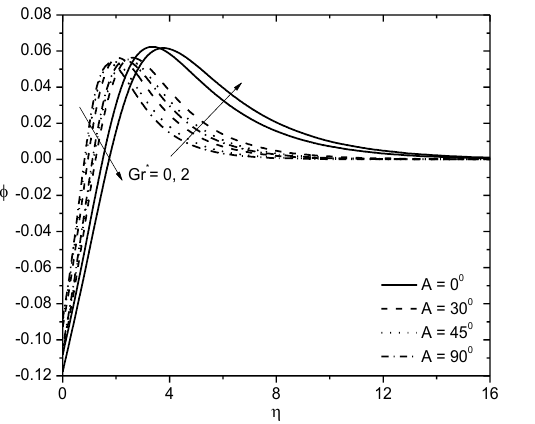
Figure 5. Effects of Gr * and A on the regular concentration